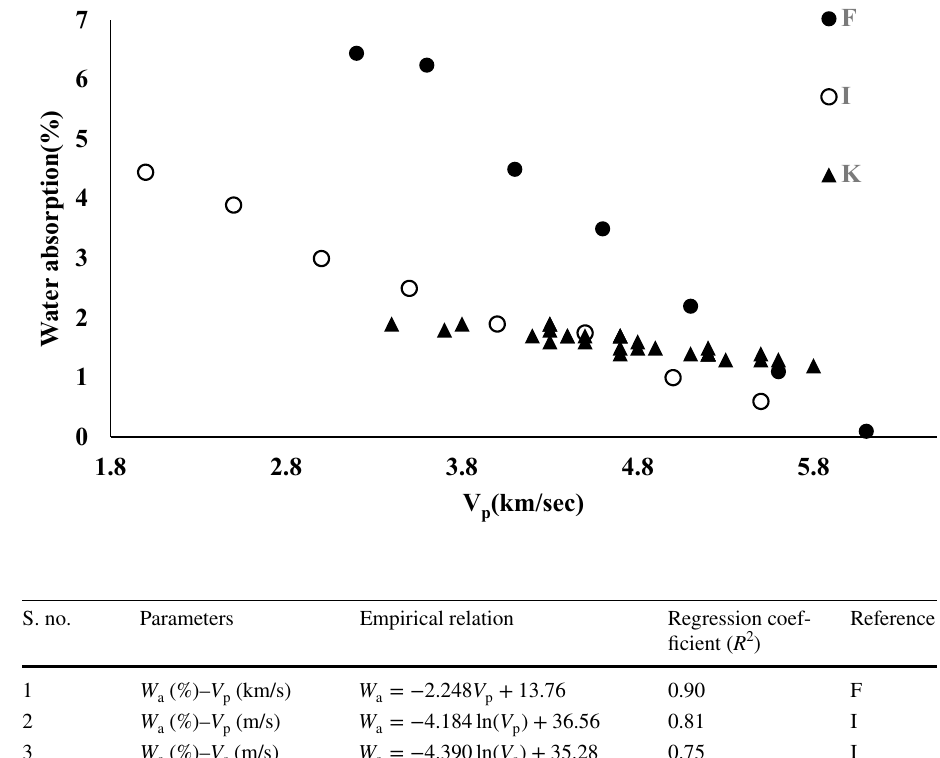
Table 6 Compilation of empirical equations derived for velocity ( V p , V s ) and water absorption as reported by various researchers